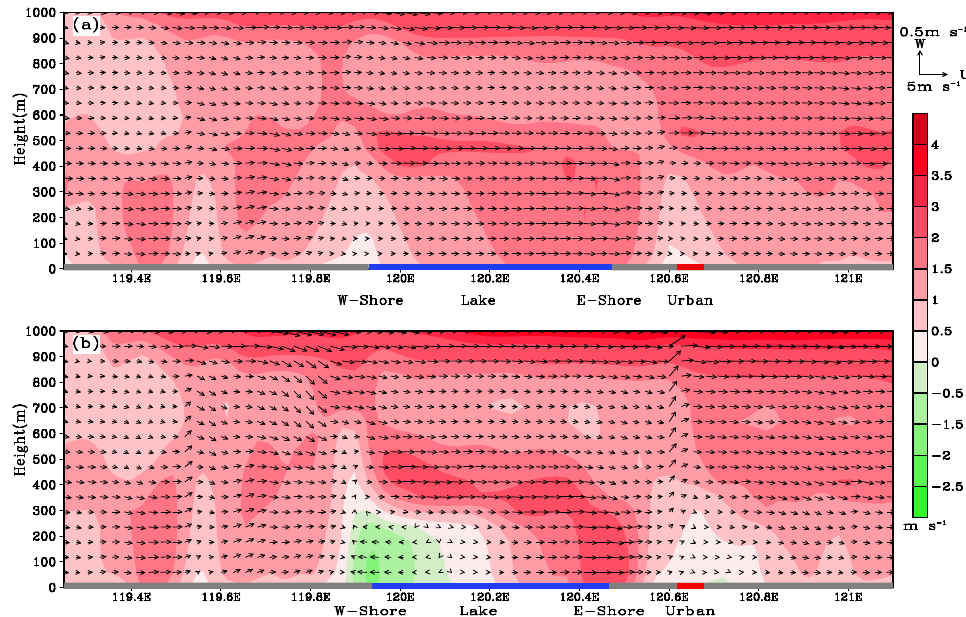
Figure 9. Cross-section of wind vector along the center latitude (31.2 °N) at 09:00 19 July 2012 by ( a ) Figure 9. Cross‑section of wind vector along the center latitude (31.2 S-Lake; ( b ) D-Lake. ( a ) S‑Lake; ( b )